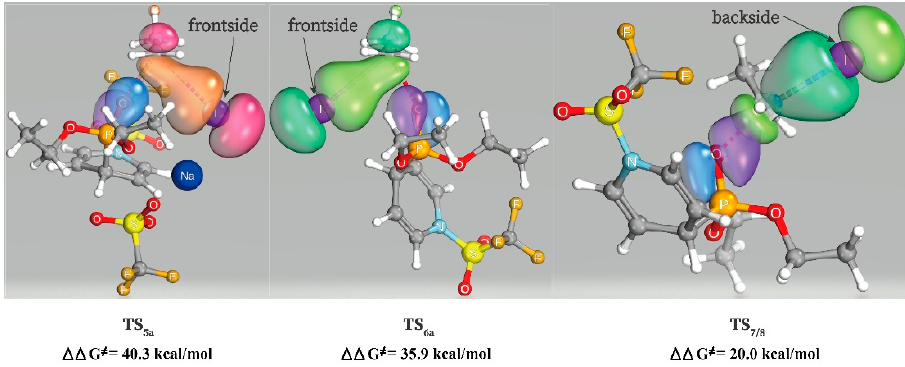
Figure 4. Orbital interactions implicated in the three S N 2 transition states: TS 5a , TS 6a , and TS 7/8